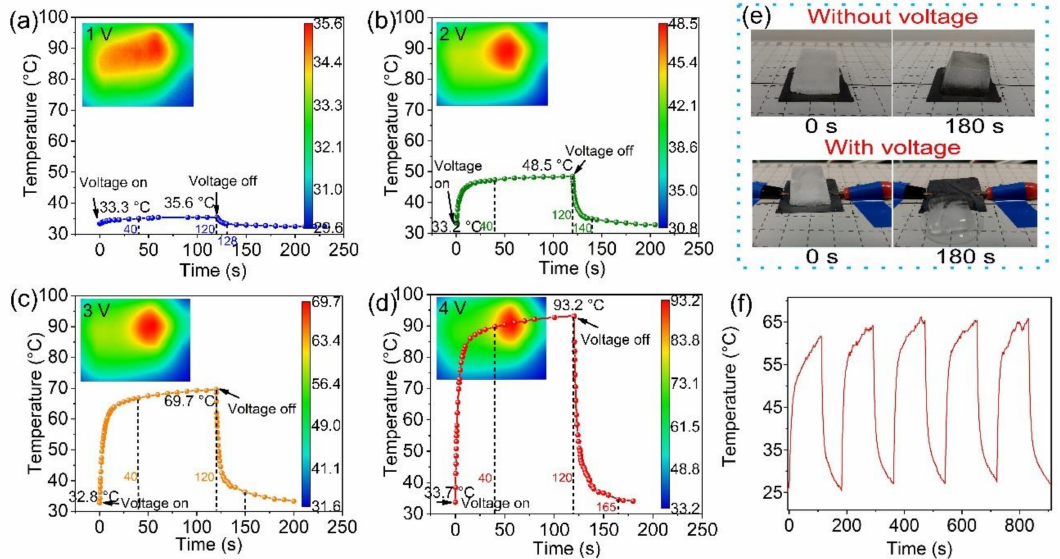
Figure 4. Electro-thermal response of the CFG film (30 × 30 mm 2 ) applied with voltages of ( a ) 1 V, ( b ) 2 V, ( c ) 3 V, and ( d ) 4 V. ( e ) Comparison of rapid deicing effect of the CFG film without and with voltage (4 V). ( f ) The repeated experiment at 3